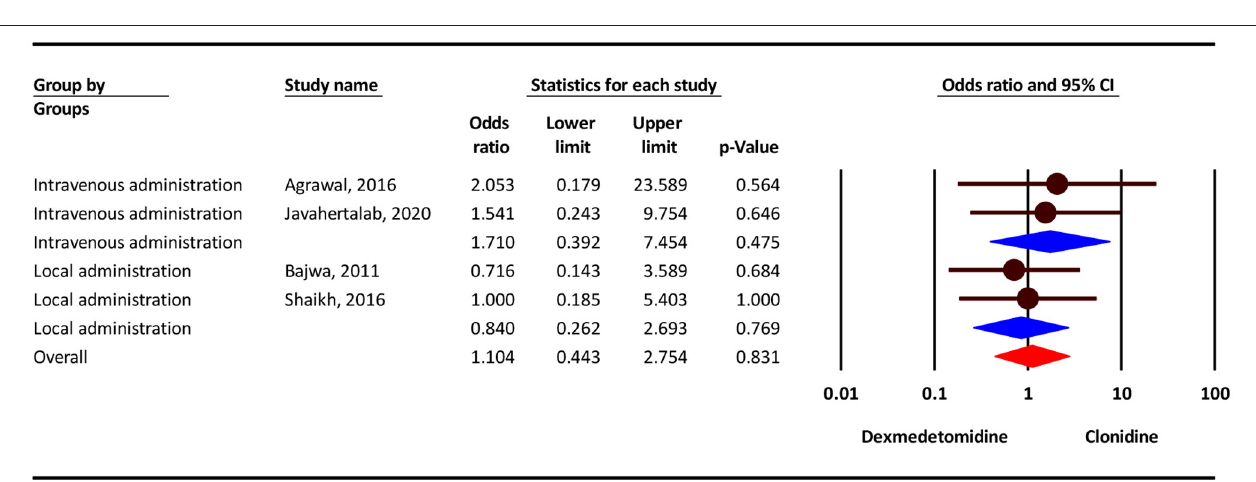
FIGURE 4 | Odds ratio for the risk of Dizziness/Headache as an adverse event associated with the adjuvant use of dexmedetomidine and clonidine in intravenous and local